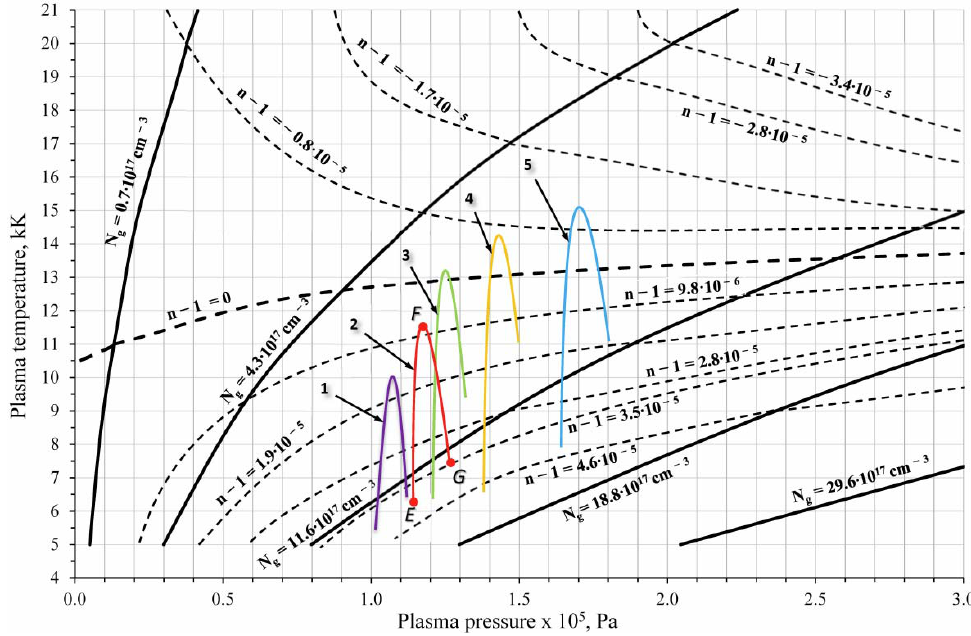
Figure 8. Parameters in the plasma for fringes # 10 (1), 20 (2), 30 (3), 40 (4) and 50 (5). The fringes shift at each point of the curve CDEFG was determined with the interfero- grams (see Figure 7) in the terms of the ∆ m abs absolute values, i.e., relative to the vacuum fringe VV . The points were indicated for fringe #20 in Figure 7d. For fringes #10, #30,